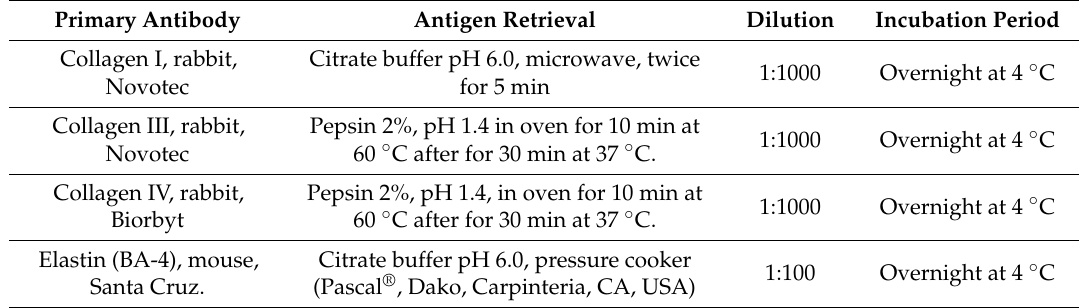
immunohistochemistry (IHC)